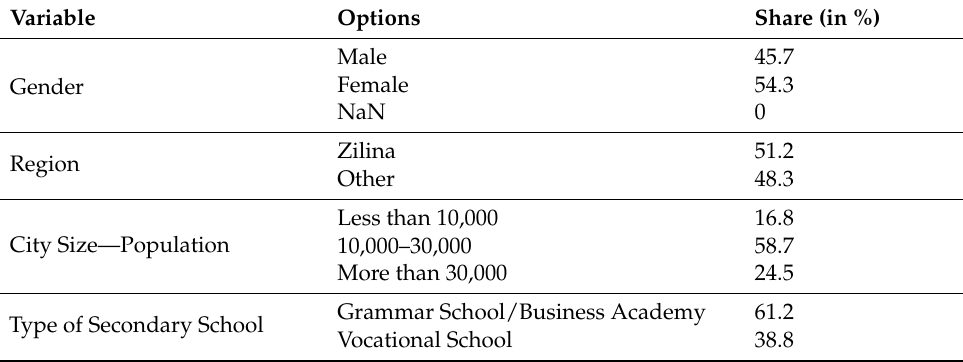
Table 3. Sociodemographic characteristics of the sample.